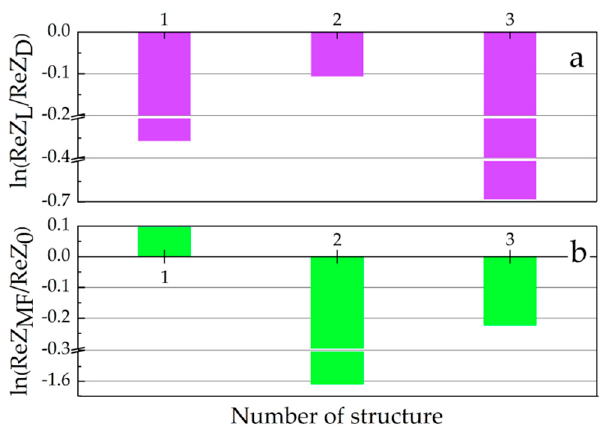
Figure 8. Photo-( a ) and magnetoresistive ( b ) effects measured in the low-frequency region for GaSe(SC(NH 2 ) 2 ) (1), GaSe(SmCl 3 ) (2) and GaSe(SC(NH 2 ) 2 (SmCl 3 )) (3). The Nyquist plot for complex impedance for the 4-fold expanded non-intercalated GaSe matrix (see Figure 10) demonstrates a classic two-arch shape. High-frequency and low-frequency arches represent current flow, in packages of unexpanded crystal lattice layers, and between them, respectively. The lowest frequency dispersion is also worth mentioning, because it reflects the quantum capacity [33] caused by the discretization of the energy spectrum perpendicularly to the layers. Energies 2020 , 13 , x FOR PEER REVIEW